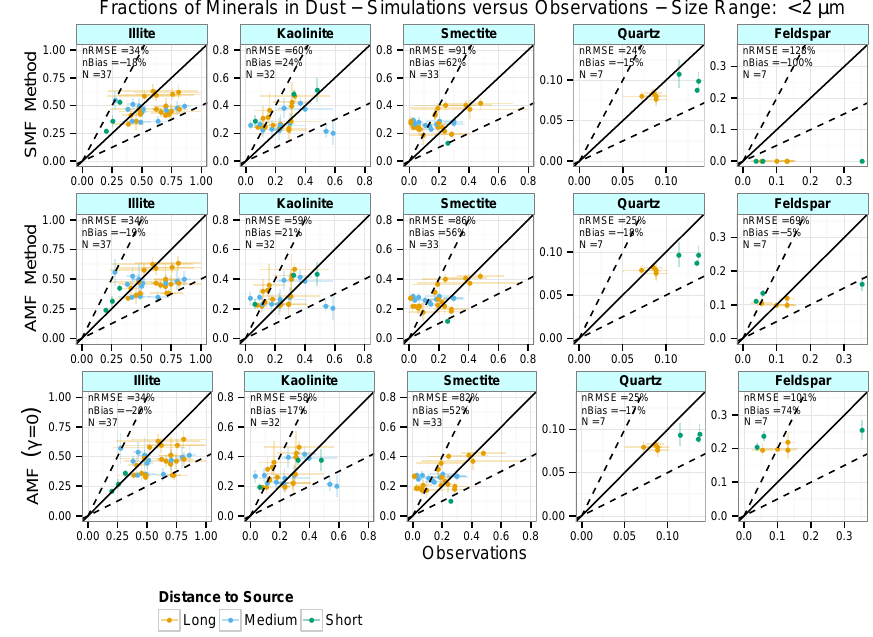
Figure 5. Same as Fig. 4 but for illite, kaolinite, smectite, quartz, and feldspar at clay diameters (less than 2µm).